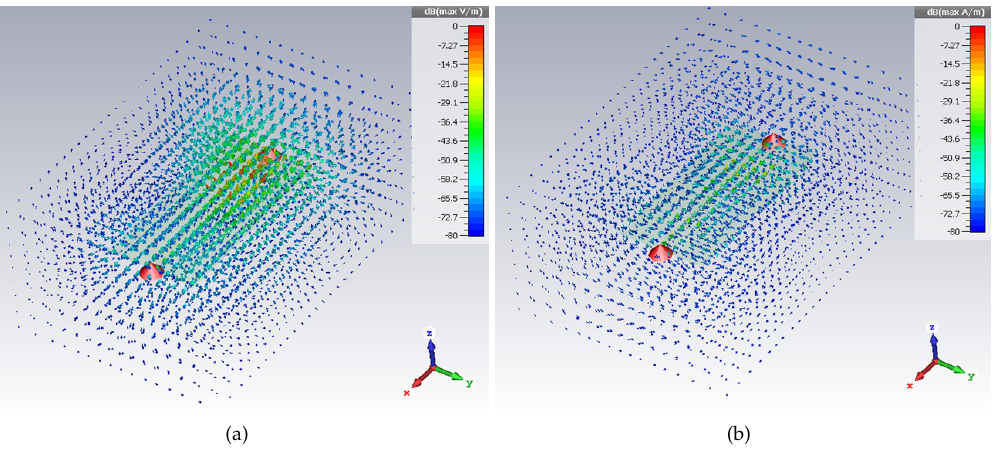
Figure 3. Simulation results of the electric field ( a ) and of the magnetic field ( b ), evaluated at 2.1 GHz, for the multi-stopband